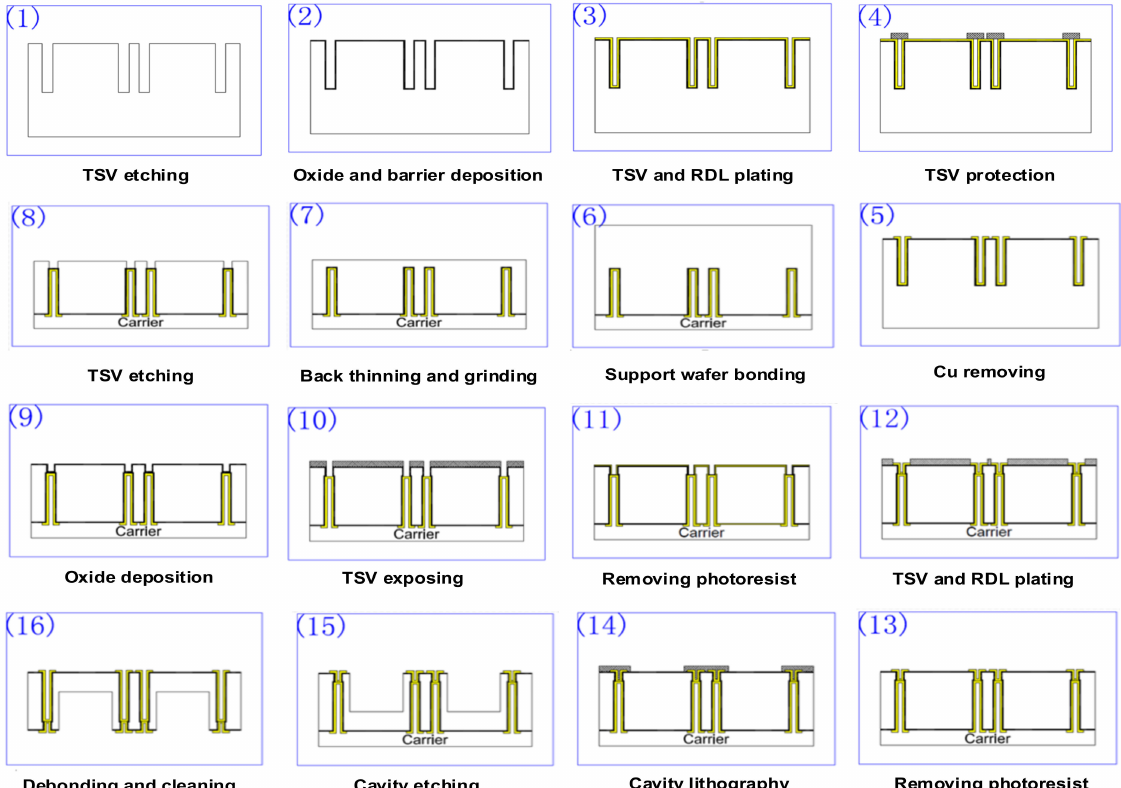
Figure 6. Process flow of the cap HR-Si interposer